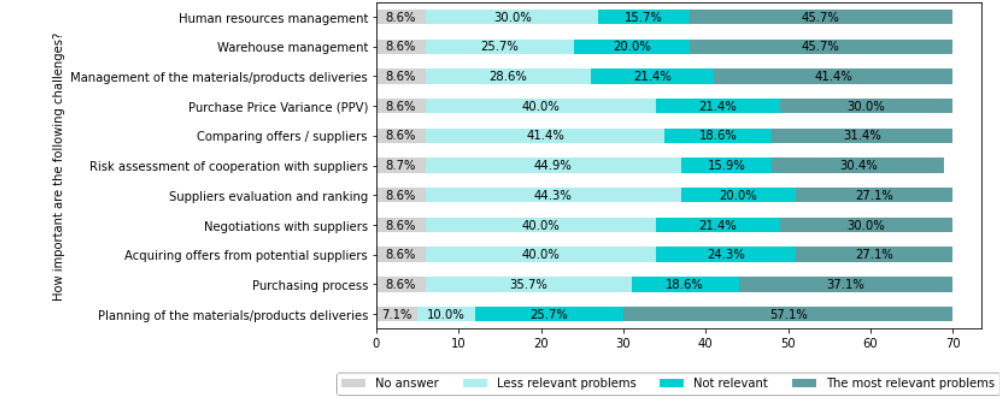
Figure 17. Challenges related to manufacturing process preparation — number of questionnaires in a total number of 70 questionnaires.